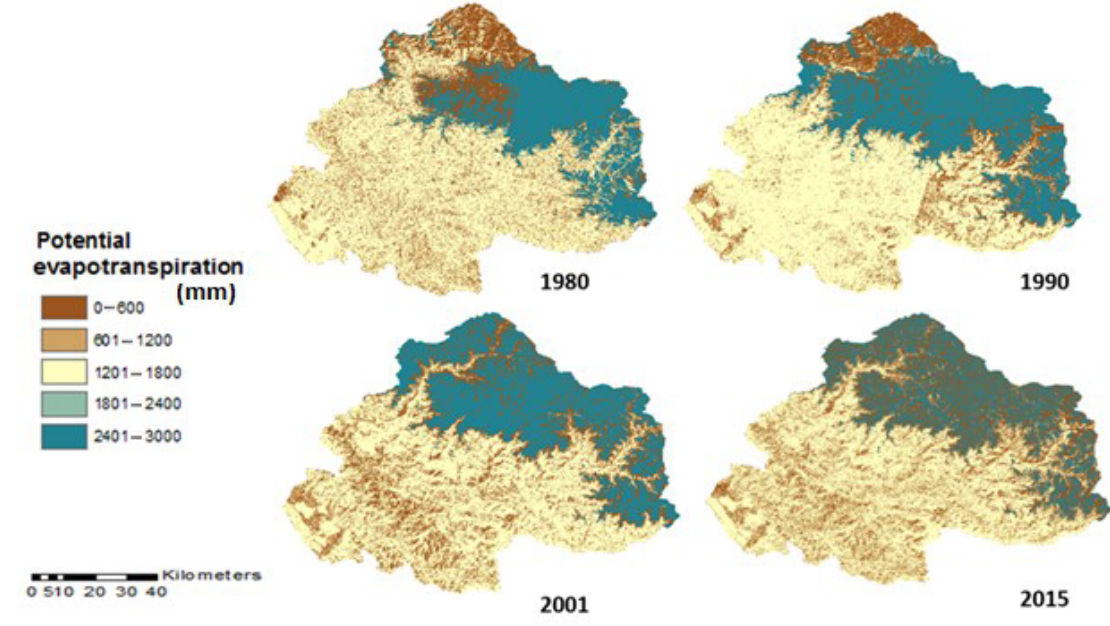
Figure 3. Potential evapotranspiration (mm) of the upper Ganga Basin for the years 1980, 1990, 2001 and